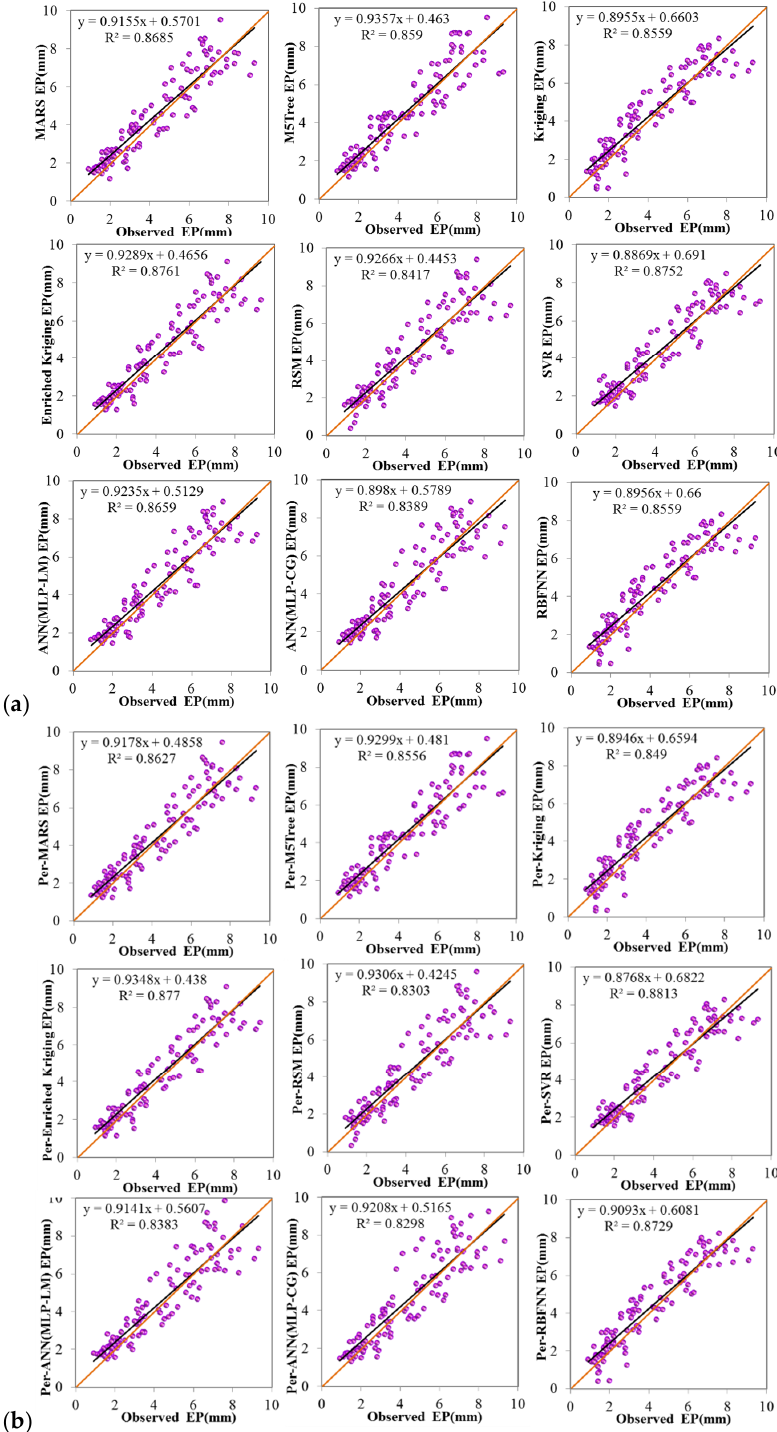
Figure 6. The observed and estimated EP ( a ) without and ( b ) with periodicity for Adana station in the testing period.